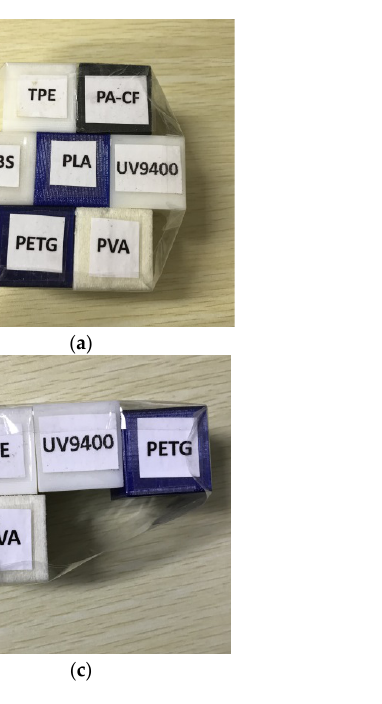
Figure 2. ( a ) Composition of training-set specimen including TPE, PA-CF, ABS, PLA, UV9400, PETG, and PVA ( b ) Composition of test-set specimen No.1 including PA-CF, ABS, PLA and two kinds of interfering samples ABS (cylinder), PVC ( c ) Composition of test-set specimen No.2 including TPE, UV9400, PETG, and PVA